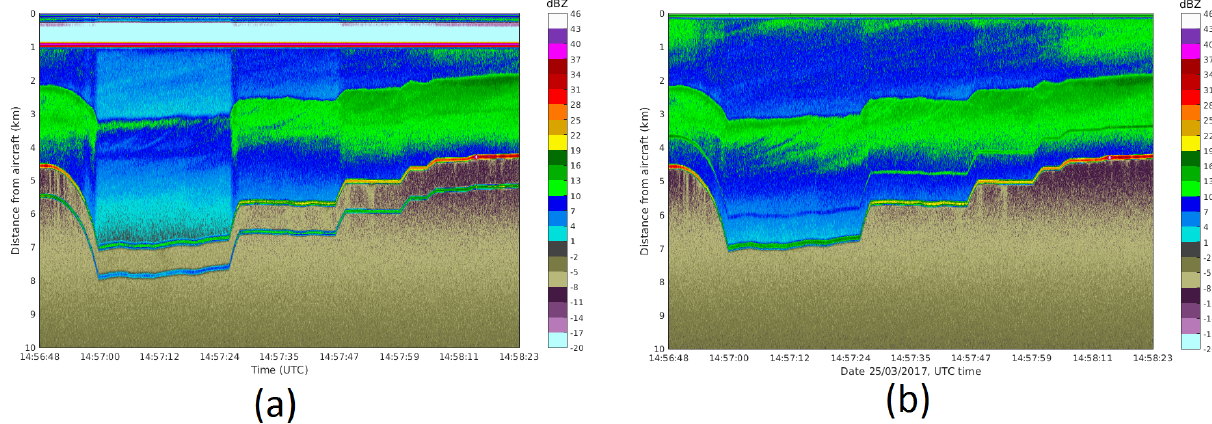
Figure 15. Similar to Fig. 9 but for 25 March flight and in reflectivity space. The PDPP spacing in this case is 6µs.